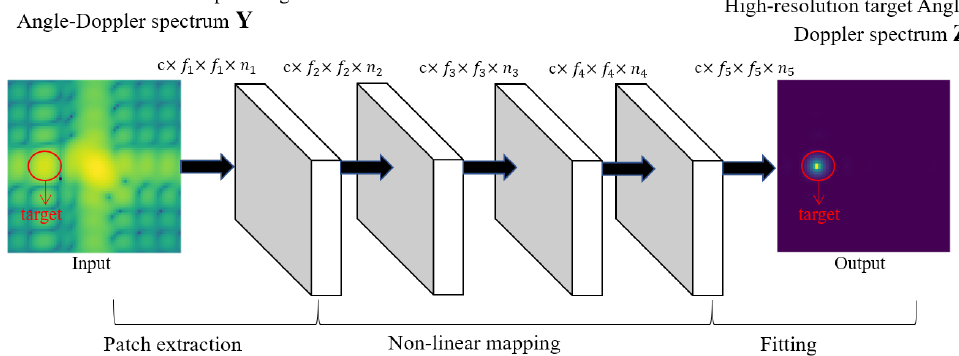
Figure 3. Architecture of the proposed convolutional neural